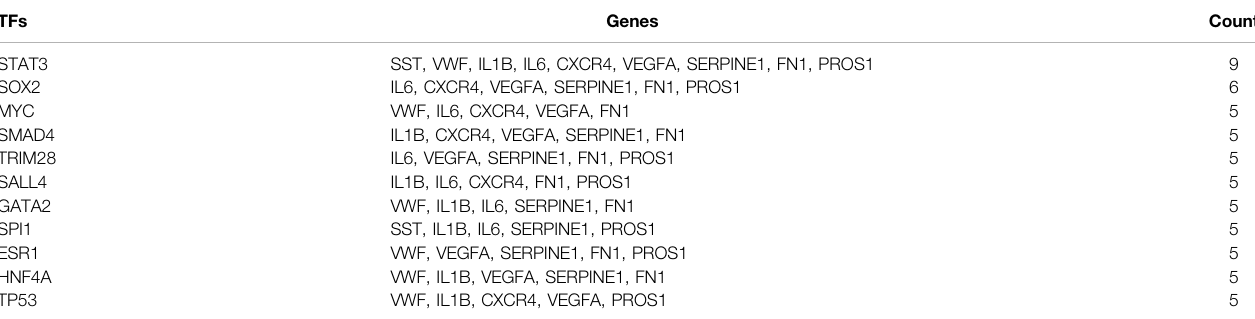
TABLE 3 | Summary of potential TFs of hub